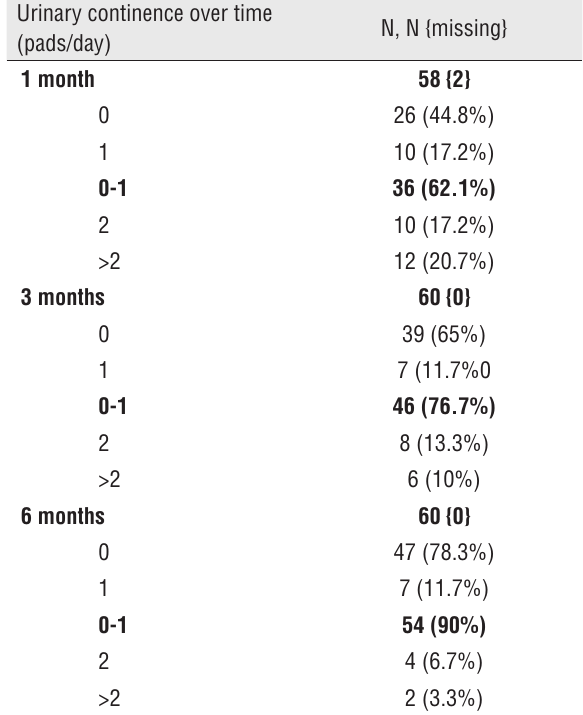
Table 5 - funcional outcome. Urinary continence over